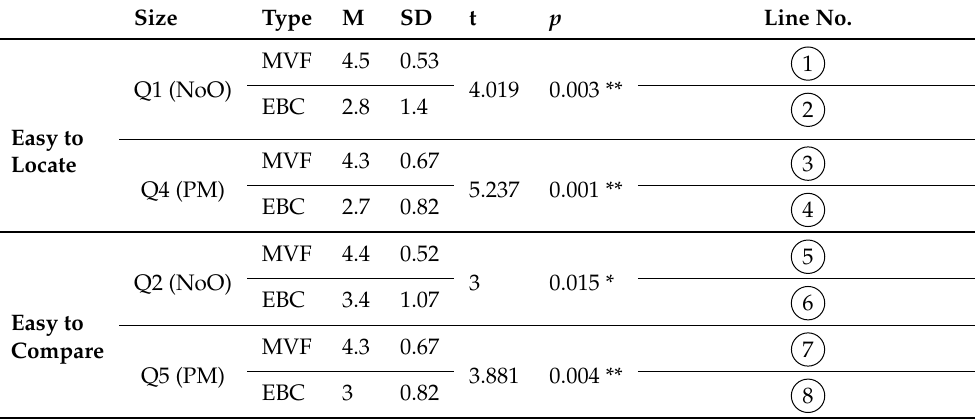
Table 4. Means of Likert scale questionnaire, with the standard deviation of the measured mean in seconds. Differences in accuracy are indicated by *. Significant differences in accuracy are indicated by